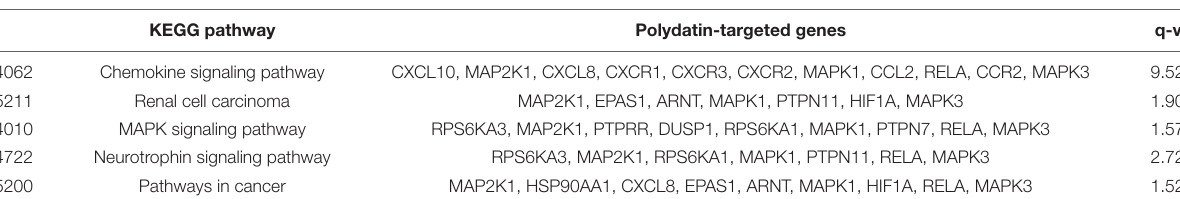
TABLE 2 | Top five KEGG pathway and related genes.